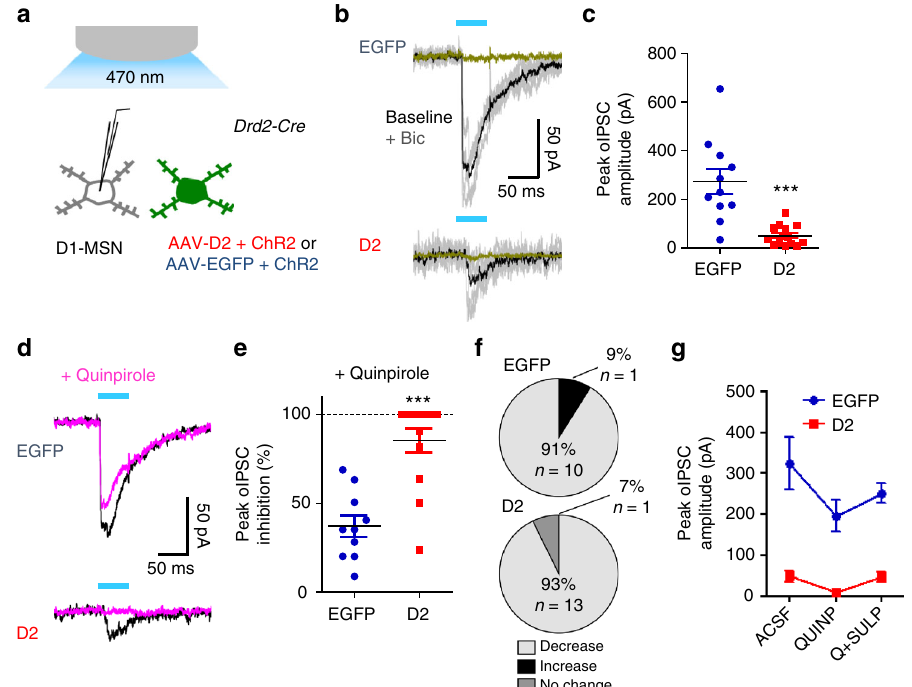
Fig. 2 D2R upregulation in D2-MSNs leads to reduced local collateral transmission. a Inhibitory postsynaptic currents (IPSCs) were evoked by blue light illumination of MSNs co-expressing ChR2 and D2R or ChR2 and EGFP in NAc slices. oIPSCs were recorded from neighboring non- fl uorescent MSNs. b Individual (gray) and average (black) traces oIPSC traces (gray) from representative MSNs following fi ve 50-ms light pulses (1 Hz). Bicuculline (10 µ M) eliminated the oIPSC. c Peak oIPSC amplitude under basal conditions was signi fi cantly reduced when D2Rs were overexpressed in D2-MSNs [ n = 11 cells (6 mice) or 14 cells (9 mice)]. d , e Treatment with quinpirole (1 µ M) reduced oIPSC amplitude in both groups, though to a greater extent in D2R-OE mice [ n = 10 cells (6 mice) or 14 cells (9 mice)]. f Quinpirole showed an inhibitory effect on oIPSC amplitude in >90% of cells recorded in both groups. g Sulpiride co-treatment (1 µ M) reversed the effect of quinpirole on peak oIPSC amplitude [ n = 7 cells (4 mice) or 11 cells (8 mice)]. Error bars =